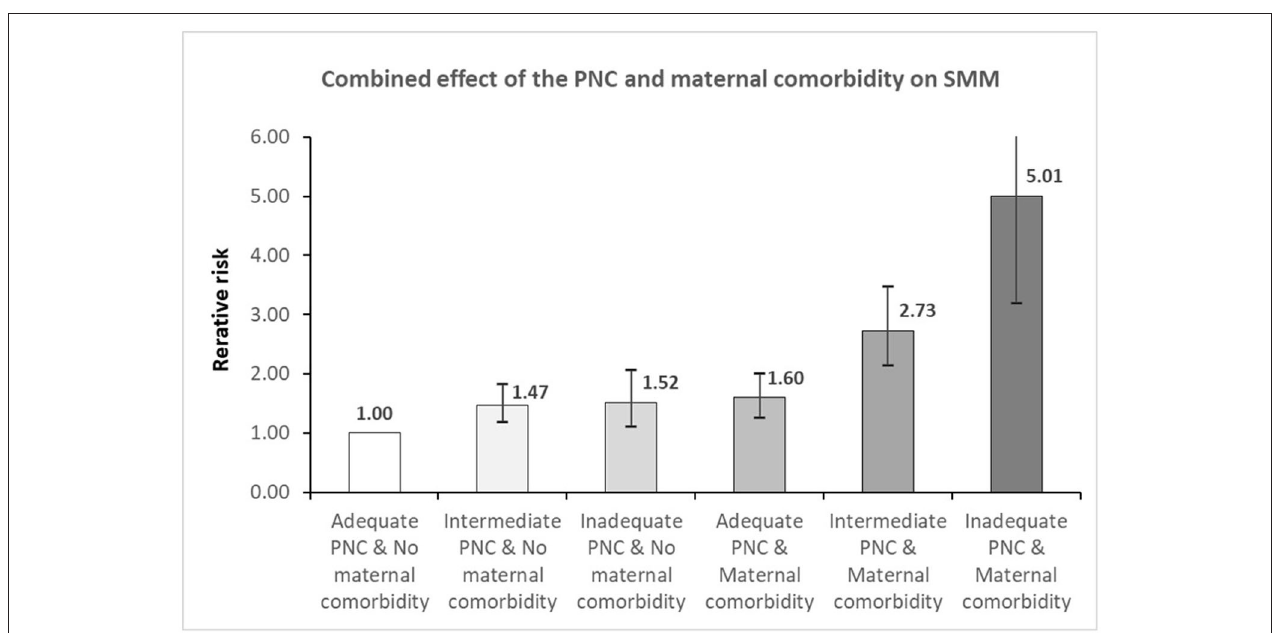
FIGURE 1 | The combination effect of the relationship between prenatal care and maternal comorbidity on severe maternal morbidity. PNC, prenatal care; SMM, severe maternal morbidity. Adjusted for maternal age, household income, type of insurance, residential area, mode of delivery, adequacy of prenatal care, parity, status of multiple birth, maternal comorbidity, type of hospital, and delivery